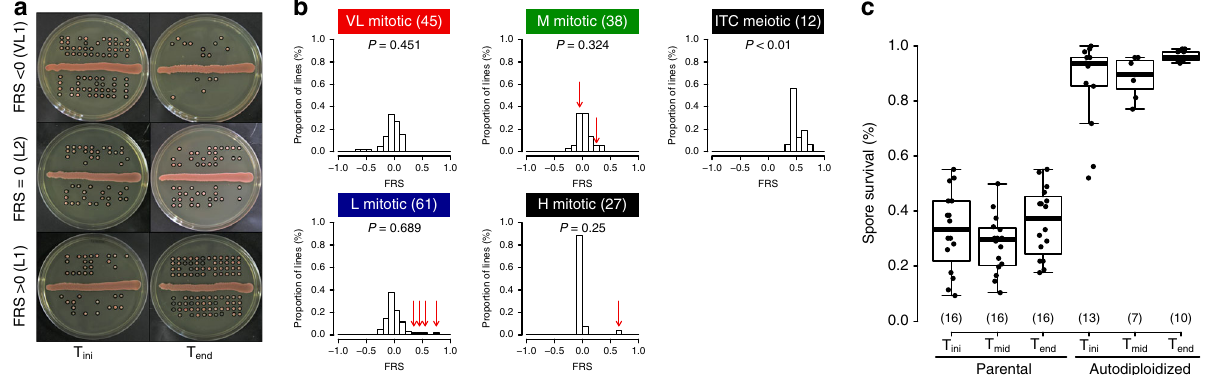
Fig. 2 Contrast in fertility changes between mitotic and meiotic propagation. a Example of spore survival from lines showing a reduction of fertility (top), no change of fertility (middle) and recovery of fertility (bottom). Spores considered as viable are circled in black. Spores from sporulation at the initial time point are shown on the left and from the fi nal time point on the right. b Fertility recovery scores (FRS), which measure the change in spore viability, show no clear directionality in mitotically propagated lines (VL div , L div , M div , and H div ). P -values given for exact binomial tests. FRS for intra-tetrad crosses (ITC) indicate large and systematic increase in fertility. Bins containing strains with high fertility by the midpoint of the experiment highlighted with red arrows. c Autodiploidization was performed on a random set of 16 haploid viable spores dissected from the L div and M div crosses at T ini , T mid and T end . Fertility of initial hybrids and evolved lines (parental) increases to above 80% after spore autodiploidization. Numbers in parentheses represent sample sizes. For all boxplots the bold center line corresponds to the median value, the box boundaries correspond to the 25th and the 75th percentile, the whiskers correspond to 1.5 times the inter-quartile range and the dots to individual data